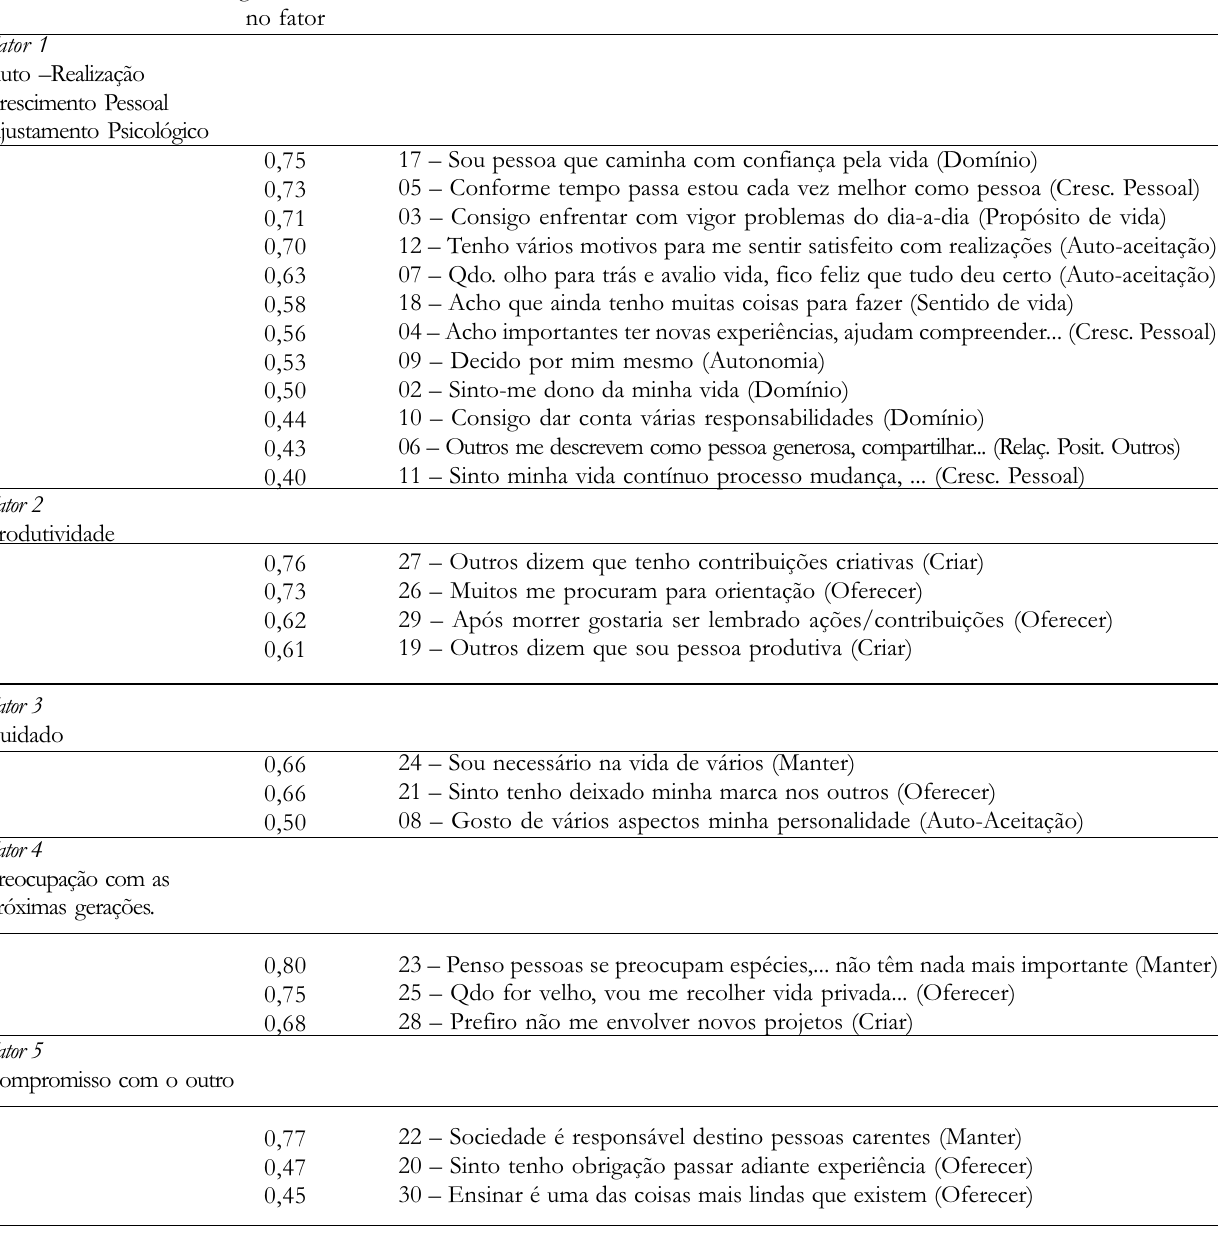
2 Estrutura Fatorial da Escala de Desenvolvimento Pessoal nos Grupos de Meia-idade e de Idosos Fatores Fator 1 Auto (cid:150)Realiza(cid:231)ªo Crescimento Pessoal Ajustamento